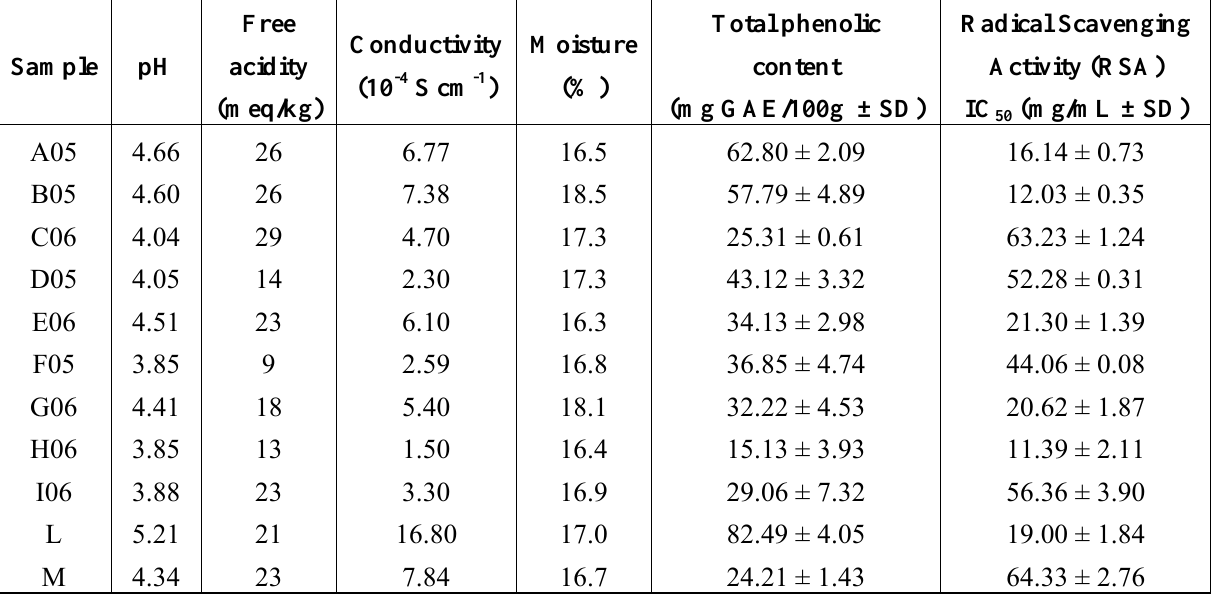
Table 2 . Physicochemical measurements, total phenolic content, radical scavenging activity (RSA) (IC ) of honey samples. 50